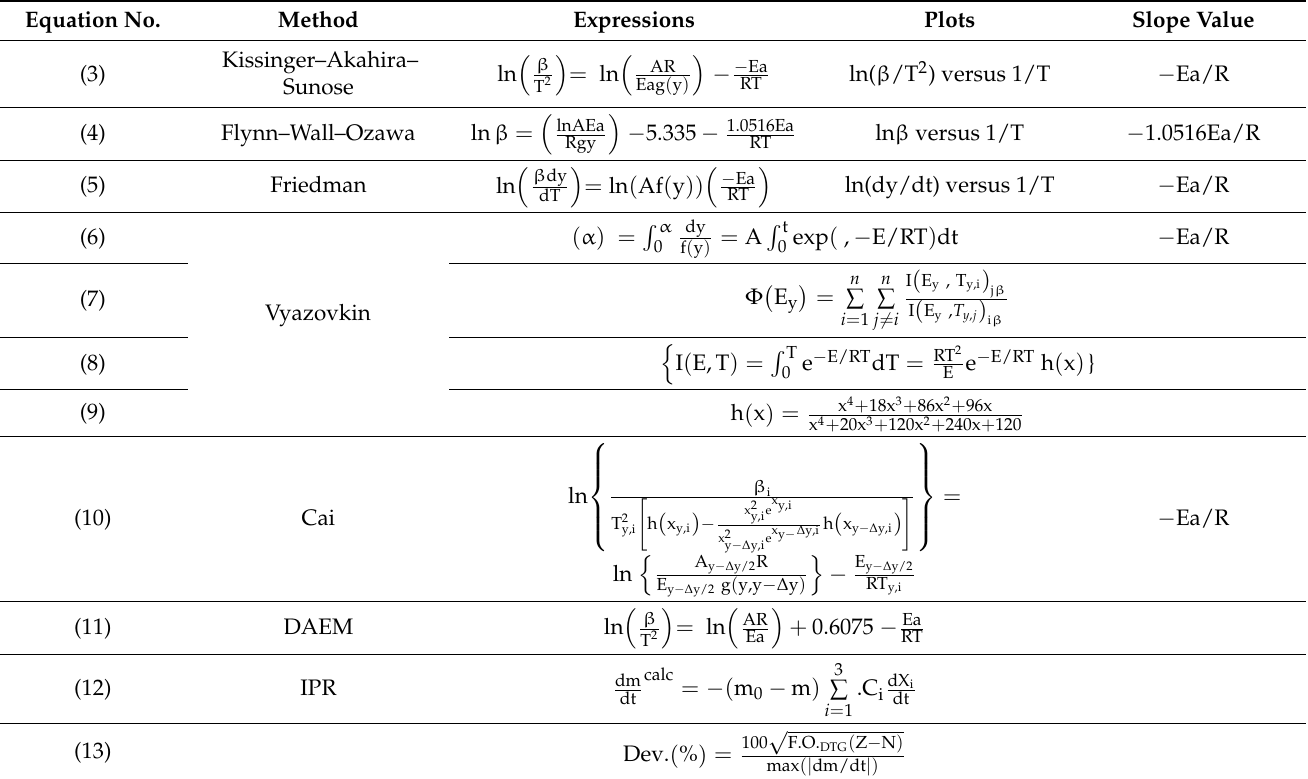
Table 1. Linear and nonlinear isoconversional methods used to determine kinetic parameters for the pyrolysis of GFRC